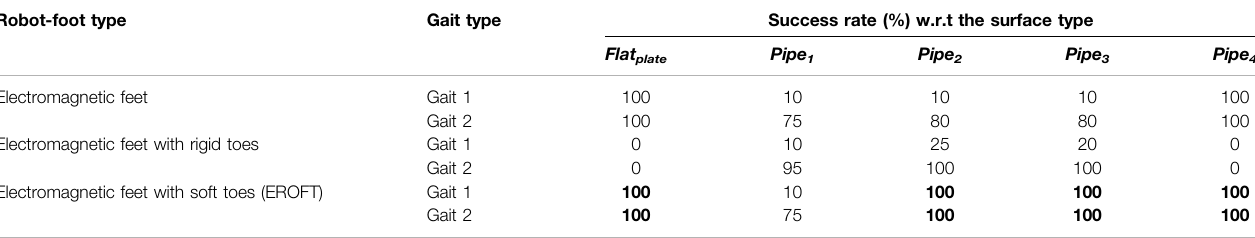
TABLE 4 | Robot crawling success rate for various metal surfaces under different